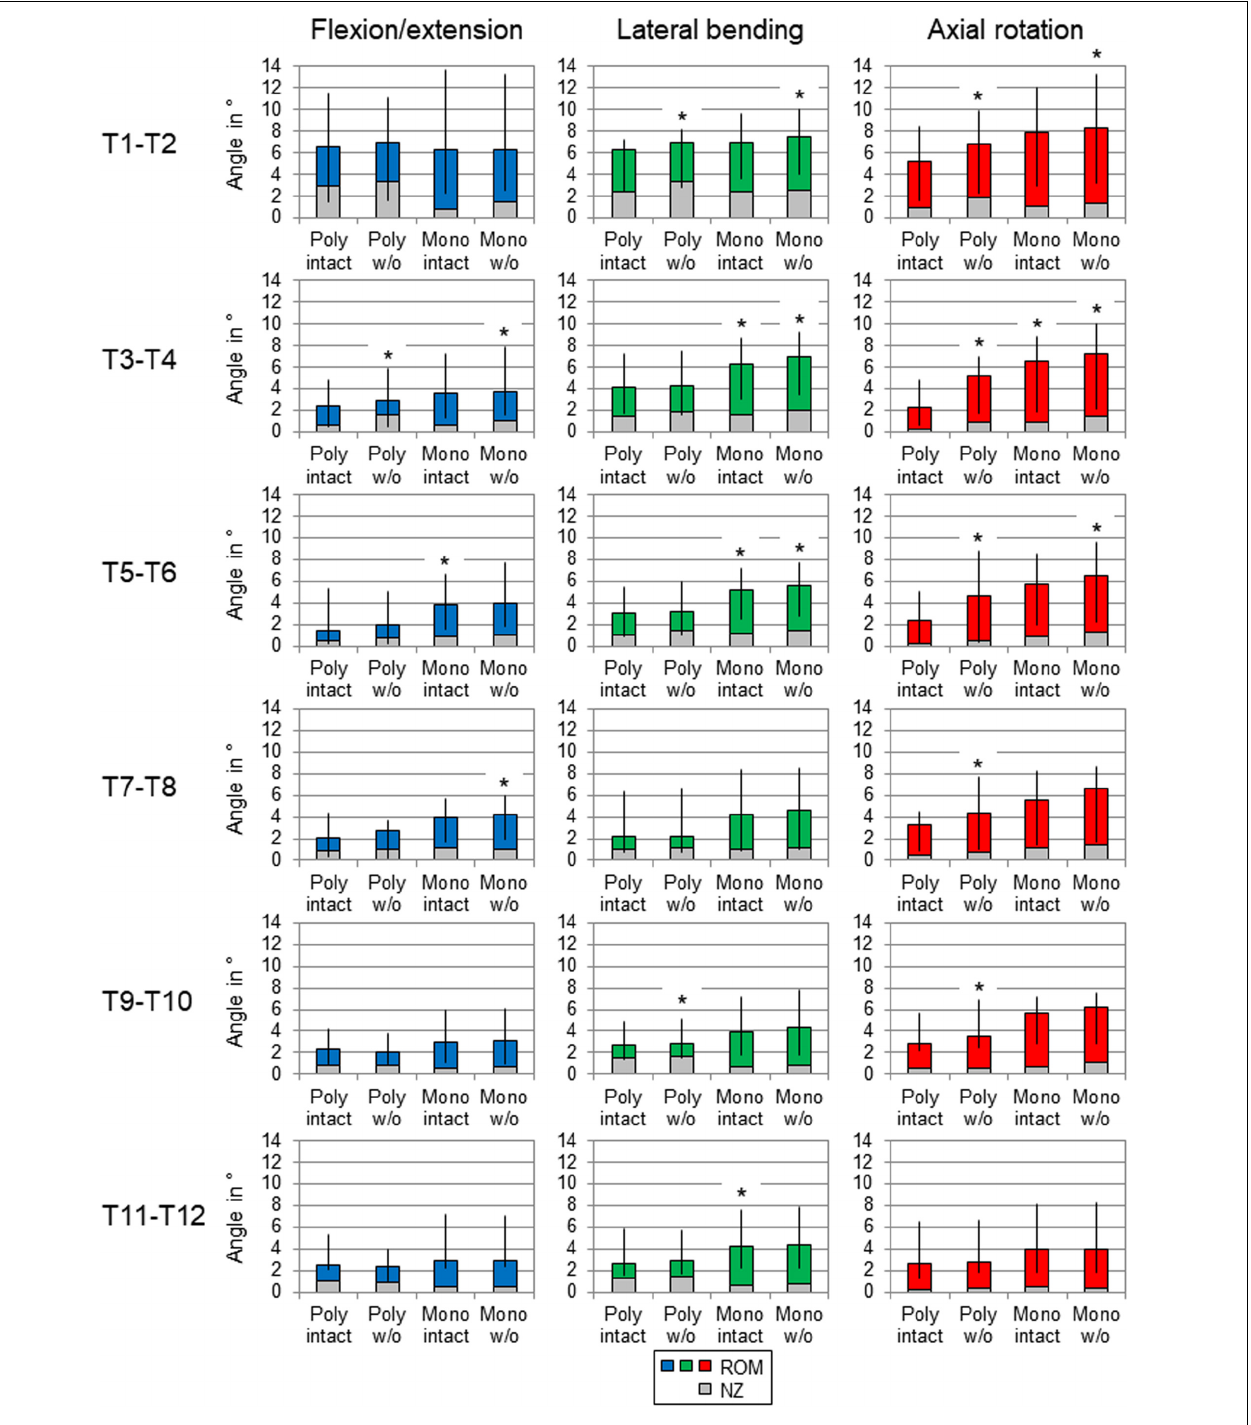
FIGURE 5 | Graphical illustration of the results for ROM and NZ of the six tested segmental levels (T1-T2, T3-T4, ... ) at pure moments of ± 5 Nm ( n = 8) depending on primary motion plane and testing step. Significant differences compared to the previous condition ( p < 0.05) are marked with an asterisk.